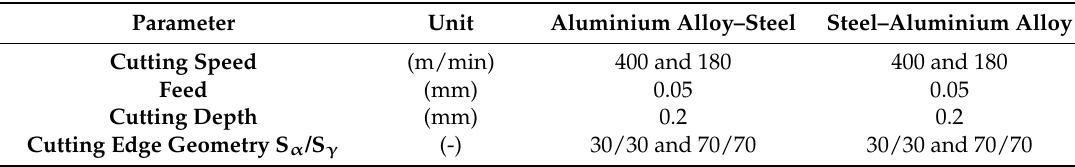
Table 3. Process parameters of the cutting operation.